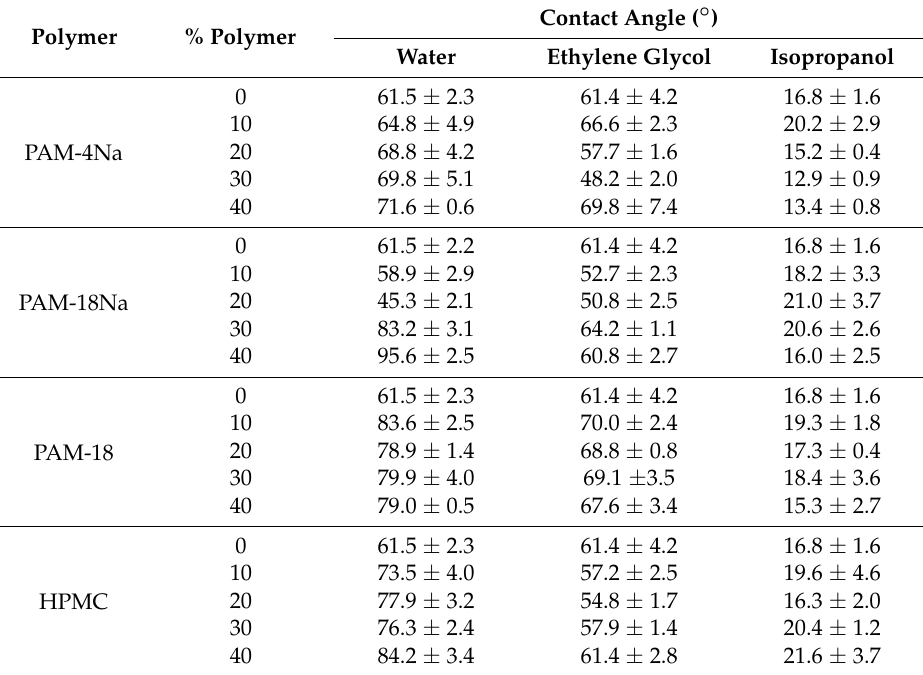
Table 3. Contact angle values ( θ c ) for ampicillin trihydrate tablets at different ratios of polymers using several reference